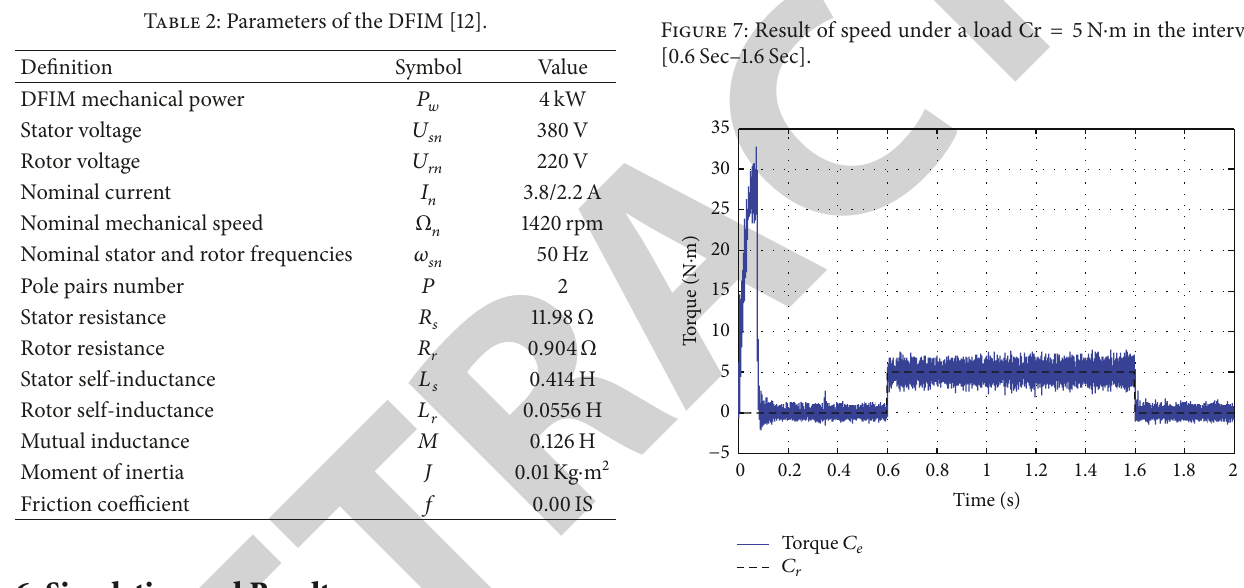
Figure 8: Result of torque under a load Cr = 5 N ⋅ m in the interval [0.6 Sec–1.6 Sec].